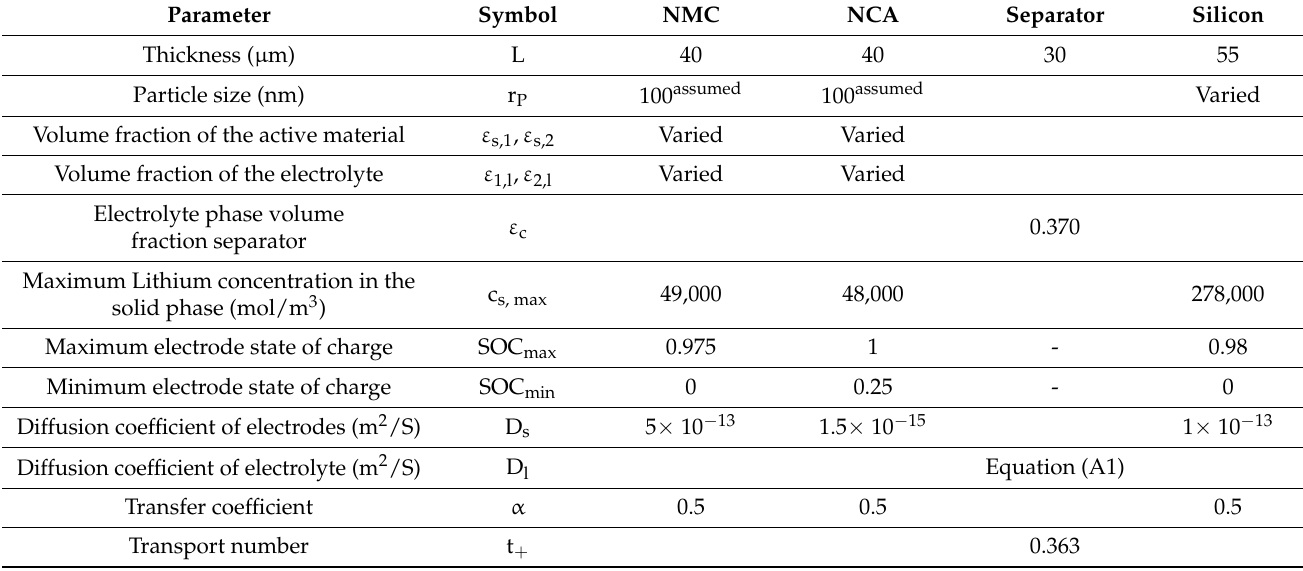
Table 3. Electrochemical model